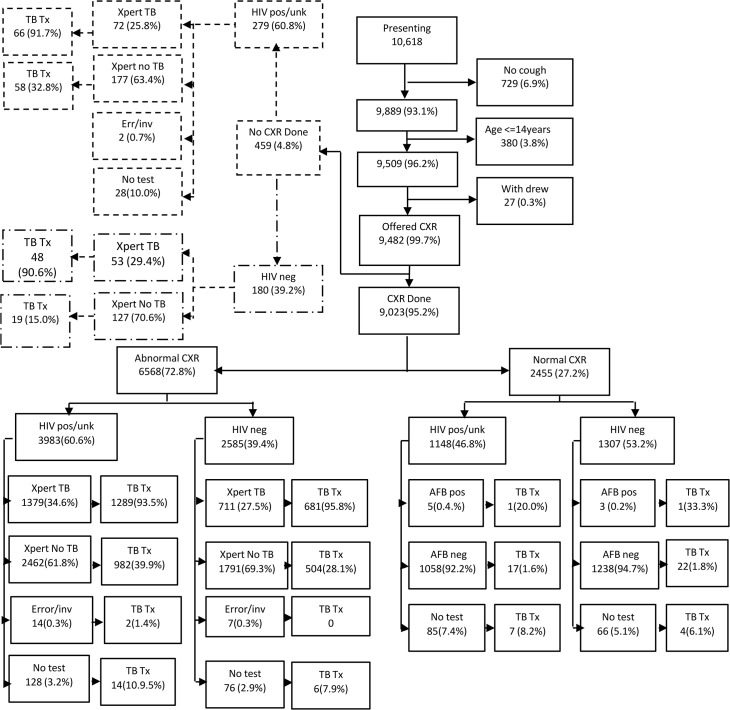
Flow of patients CXR algorithm.